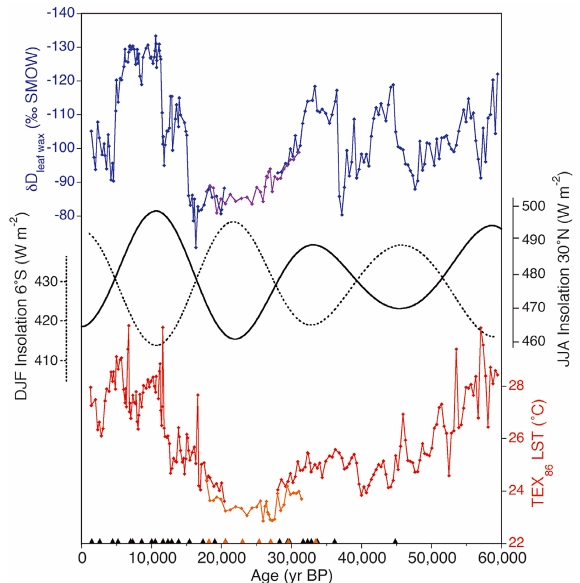
Figure 17. Temperature and precipitation proxy records from Lake Tanganyika compared with insolation. Organic geochemical in- dices TEX 86 (red) and δ D leafwax (blue) indicate temperature and monsoon precipitation, respectively. The curves follow June-July- August insolation for 30 ◦ N (solid line) of the Northern Hemi- sphere, anti-phasing the December-January-February insolation in the local area (6 ◦ S) (dotted line) (Tierney et al.,